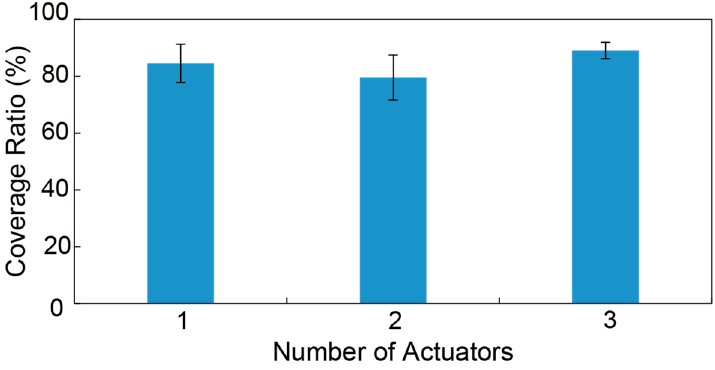
Figure 11. Comparison of coverage for each experiment.